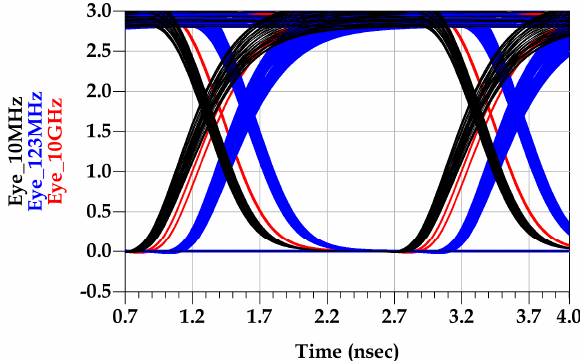
Figure 10. Output eye diagram due to last-stage PGSV variation with a L = 160 mV at 10 MHz (black), 123 MHz (blue), and 1 GHz (red).